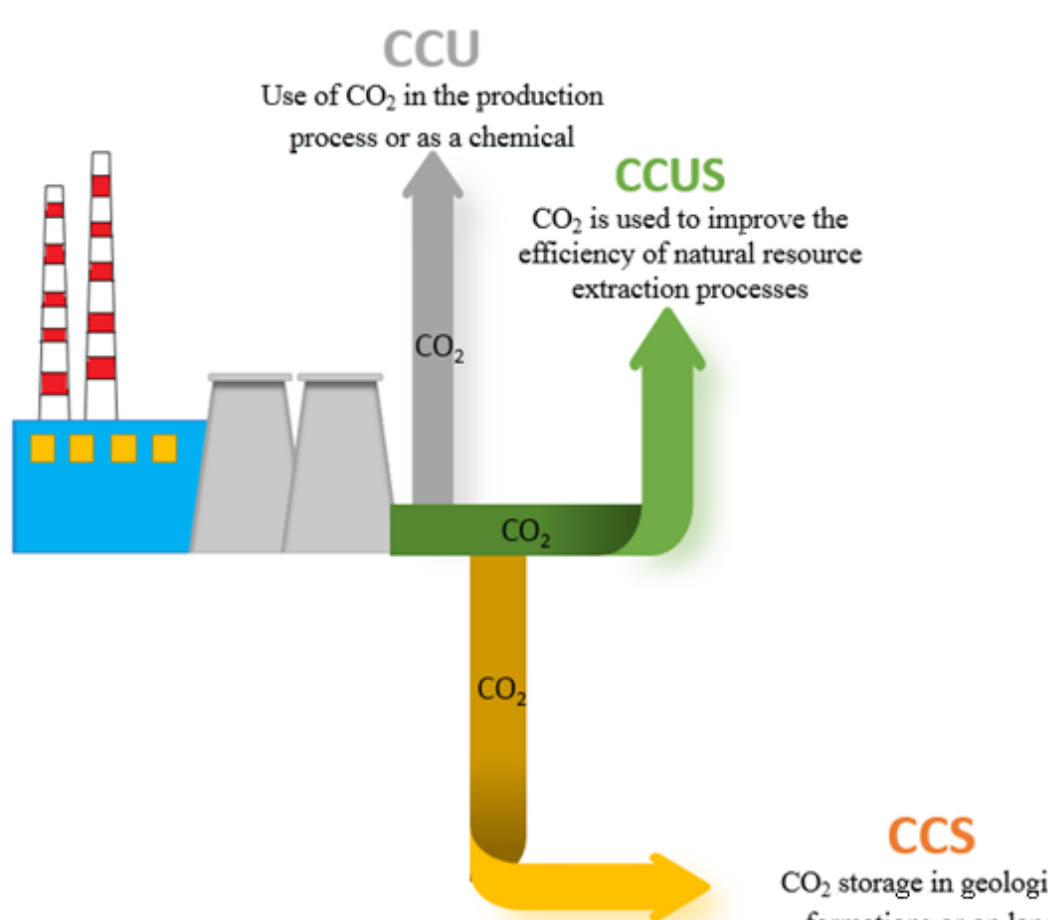
Figure 2. Schematic presentation of the technology of carbon